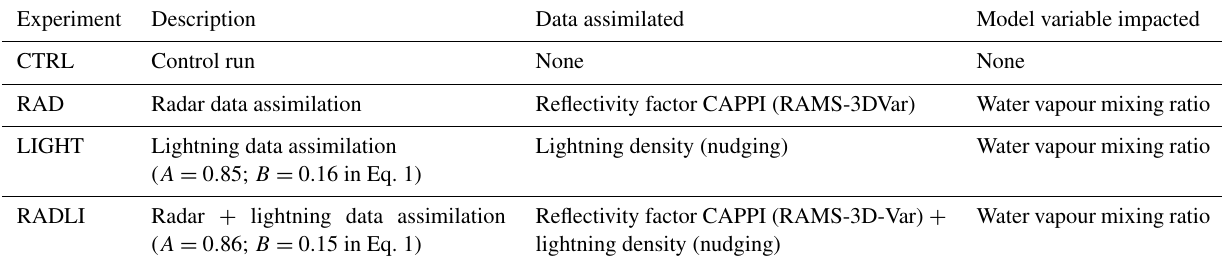
Table 3. Types of simulations performed. Experiment Description Data assimilated Model variable impacted